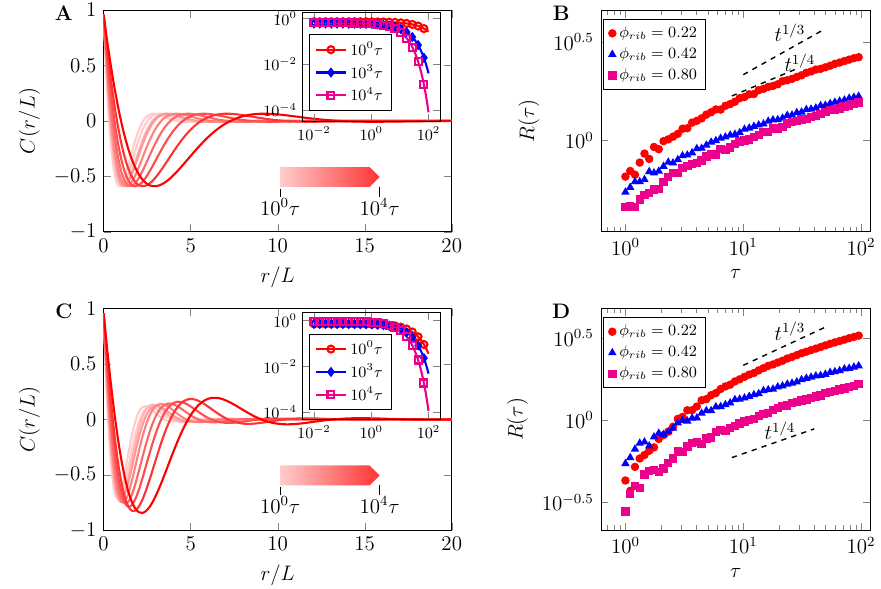
Figure 8. Normalized correlation functions ( C ( r / L ) ) and dominant characteristic length-scales At λ ): ( A ) correlation function for morphology in Figure 5A, without reactions, that is, ( R ( t ) ∼ ( φ ) = 0 and ( B ) corresponding dominant length-scale for different crowder concentrations. ( C ) R ( φ ) = 0 and ( D ) cor- Correlation function for morphology in Figure 6A, with reactions, that is, R (cid:54) responding dominant length-scale for different crowder concentrations. As can be noted in both ( B , D ), the exponent for early nucleation and growth is predominately higher than that for late stage- coarsening towards steady state regimes, λ 1/4. For the same value of crowder concentration, ∼ the growth and coarsening rates are increased when reactions are included, as can be concluded from both late modes of the correlation functions and late-stage dominant characteristic length-scales. Insert: Log–log plots of the same quantities to illustrate scaling for selected